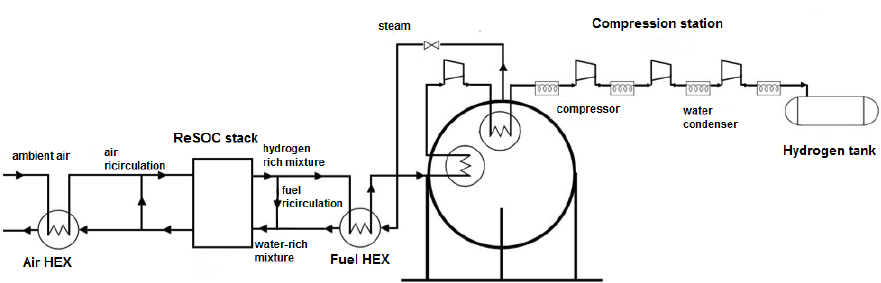
Figure 5. Condensed vapor plant configuration in SOEC